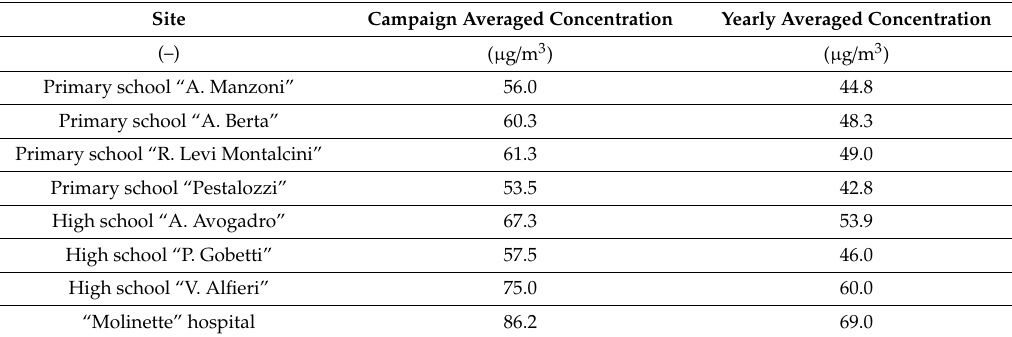
Table 2. NO 2 concentrations at the sensitive receptors for the campaign period.